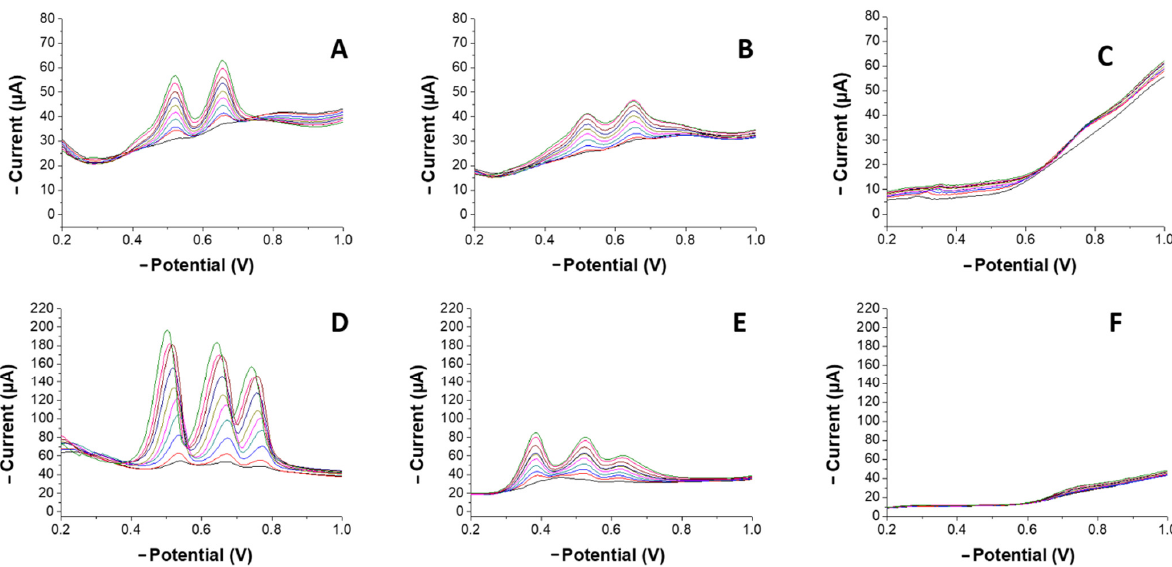
Figure 5. Voltammetric responses from 0.55 to 19 µmol L − 1 of DNP and from 0.45 to 15 µmol L − 1 TNT for the prepared sensors (each colour represents an increasing concentration of the corresponding compound). ( A ) Voltammetric response vs. DNP measured with the MIP sensor. ( B ) Voltammetric response vs. DNP measured with the NIP sensor. ( C ) Voltammetric response of DNP measured with the GEC sensor. ( D ) Voltammetric response vs. TNT measured with the MIP sensor. ( E ) Voltammetric response of TNT measured with the NIP sensor. ( F ) Voltammetric response vs. TNT measured with the GEC sensor.